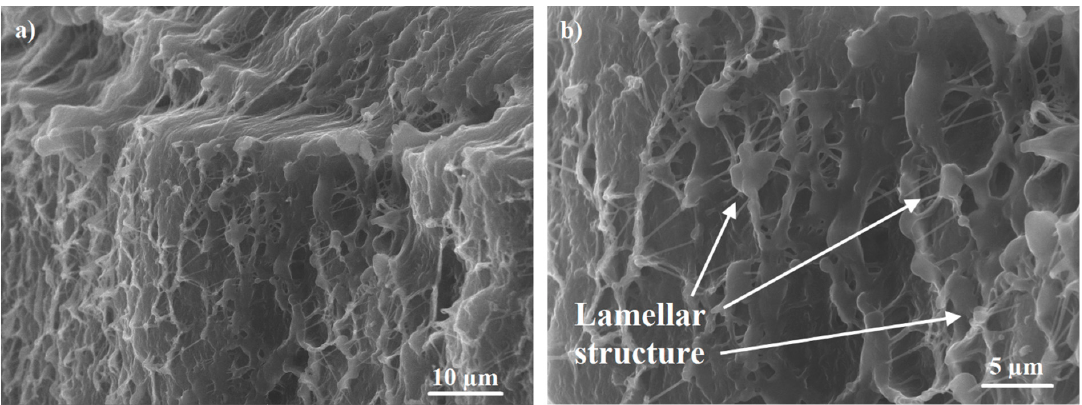
Figure 5. SEM micrographs showing typical supra-molecular structure of the virgin UHMWPE xerogel with different magnification.